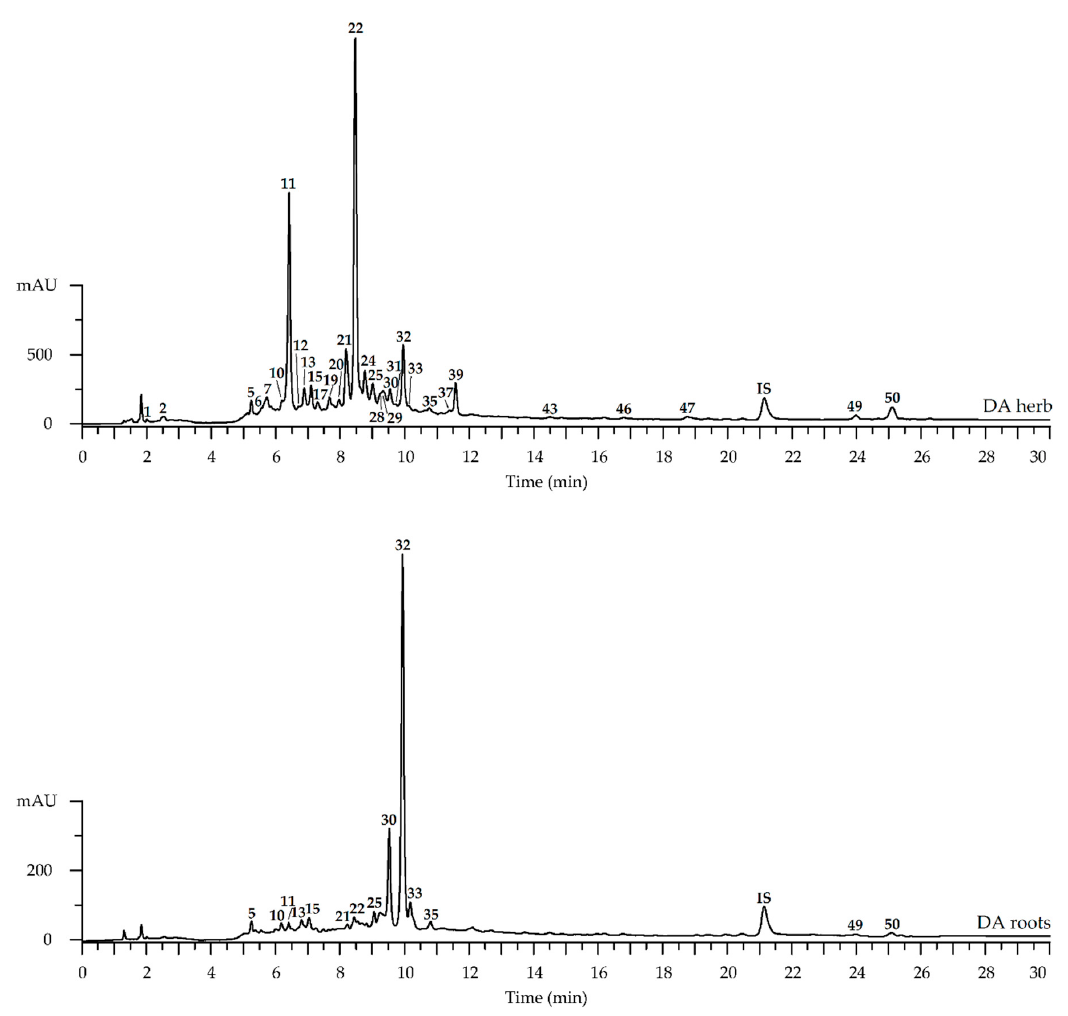
Figure 2. High-performance liquid chromatography with photodiode array detection (HPLC-PDA) chromatograms (270 nm) of herb and root extracts of Dracocephalum austriacum (DA). Compounds are numbered as listed in Table 1. IS—3 ′ ,4 ′ -di- O -acetyl-cis-khellactone (5 μ g/mL).